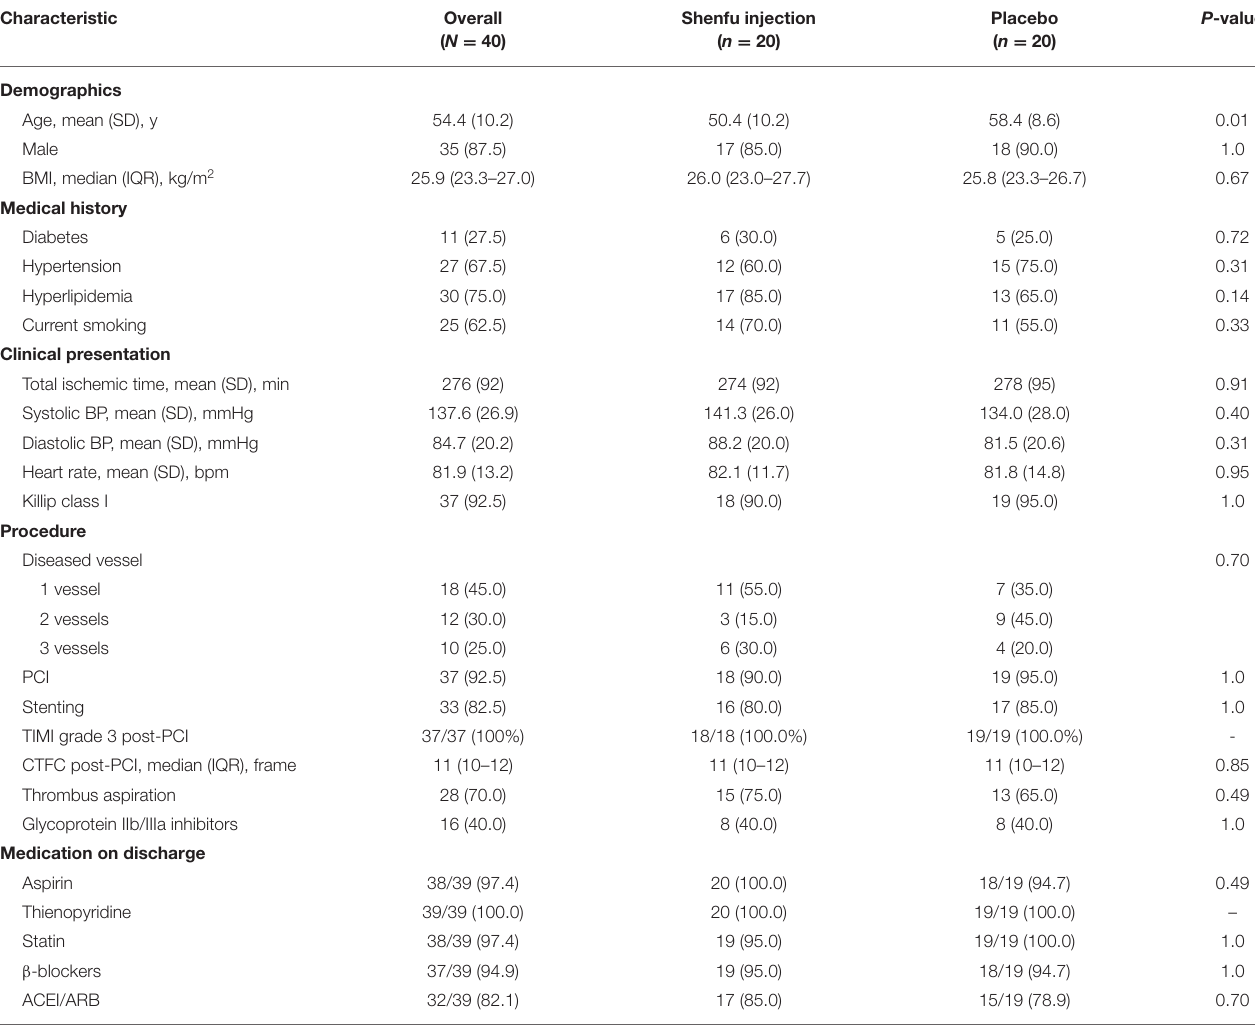
TABLE 1 | Baseline characteristics by treatment assignment.